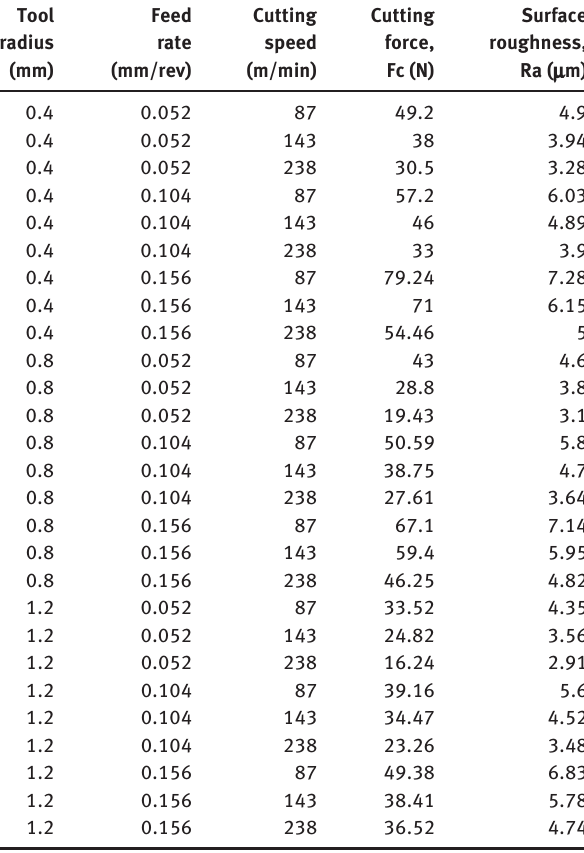
Figure 1 Experimental